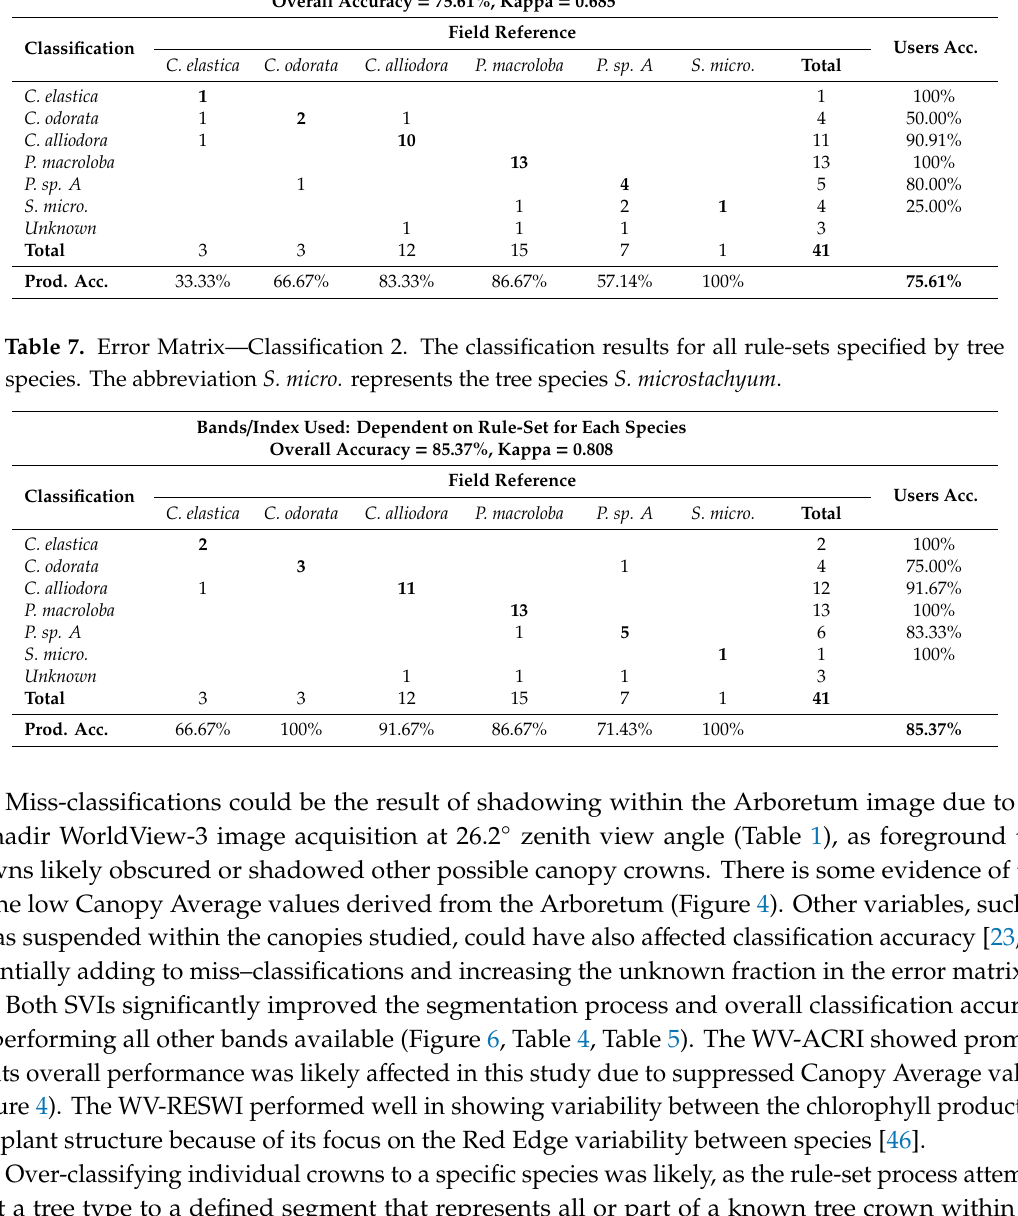
Table 6. Error Matrix Results—Classification 1. All rule-set inputs were equally weighted across all bands / SVIs for all tree species. The abbreviation S. micro. represents the tree species S. microstachyum .